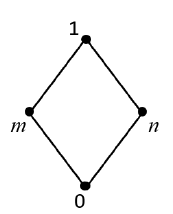
Figure 7. Lattice structure of Example